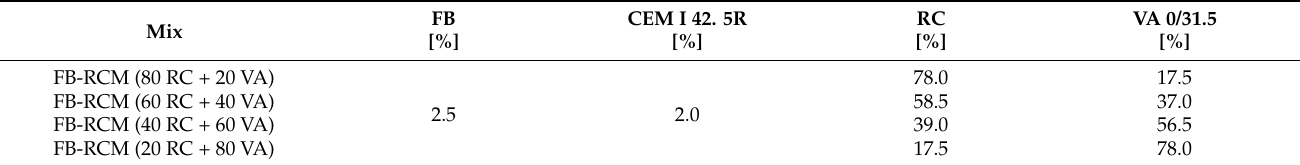
Table 9. Composition of recycled mix with recycled cement concrete (RC).